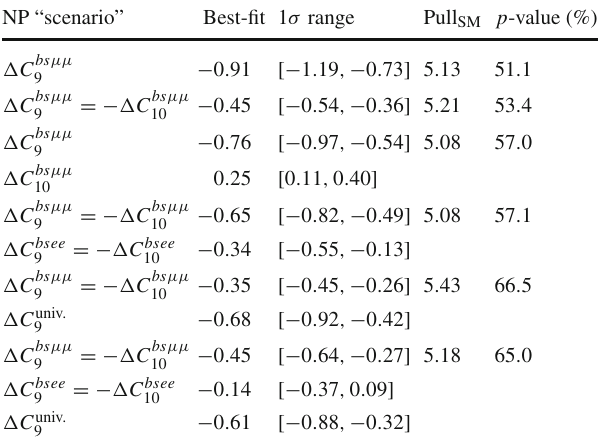
Table 1 Well-motivated NP “scenarios” (sets of Wilson coefficients) and corresponding fits to the data on angular distributions, differen- tial branching fractions and the LFUV ratios R K ( ∗ ) (not including the new measurements of LHCb [25–30]). The SM p -value is found to be ∼ 6 .